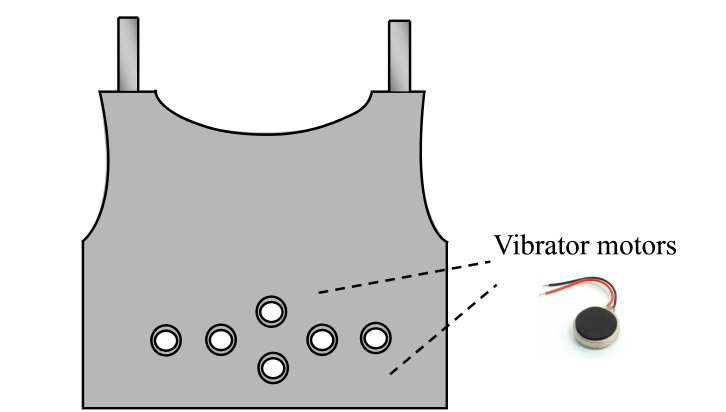
Figure 5. Location of the actuators for the tickling in the abdomen.